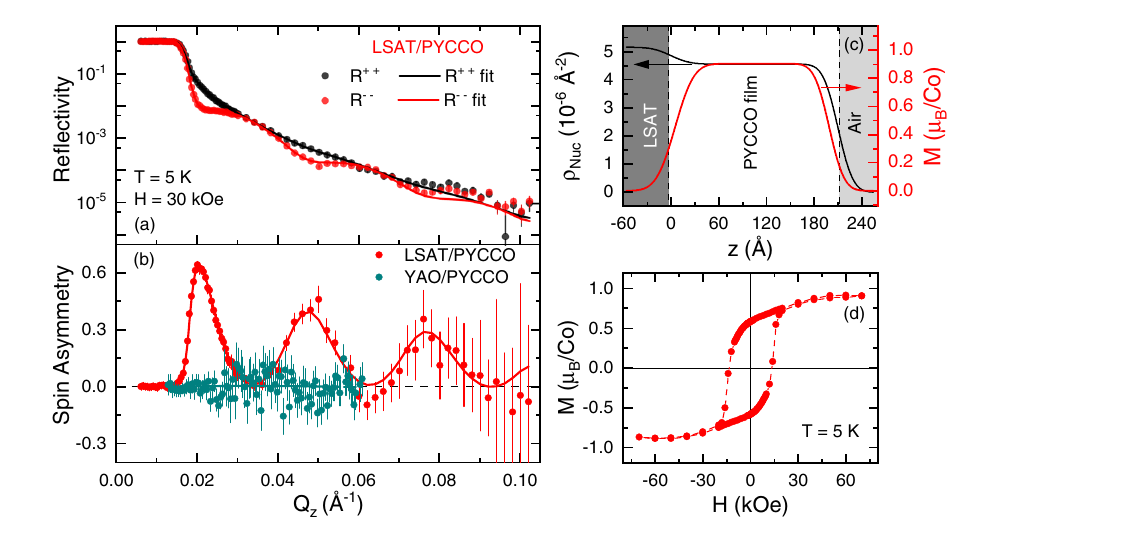
Fig. 4 | Polarized neutron re fl ectometry (PNR) characterization of ferro- magnetism in (Pr 0.85 Y 0.15 ) 0.7 Ca 0.3 CoO 3- δ fi lms. ( a ) Neutron re fl ectivity ( R ) vs. scattering wave vector magnitude ( Q z ) from a 56-unit-cell-thick (Pr 0.85 Y 0.15 ) 0.7 Ca 0.3 CoO 3- δ fi lm on LSAT(001) at 5K, in a 30-kOe (3-T) in-plane magnetic fi eld ( H ). Black and red points denote the non-spin- fl ip channels R ++ and R −− , respectively, and the solid lines are the fi ts discussed in the text. ( b ) Spin